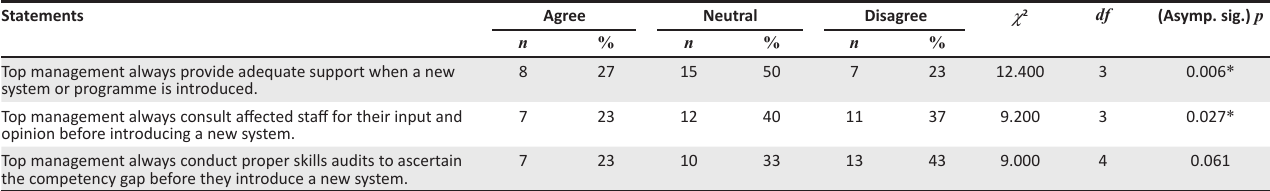
TABLE 2: Top management